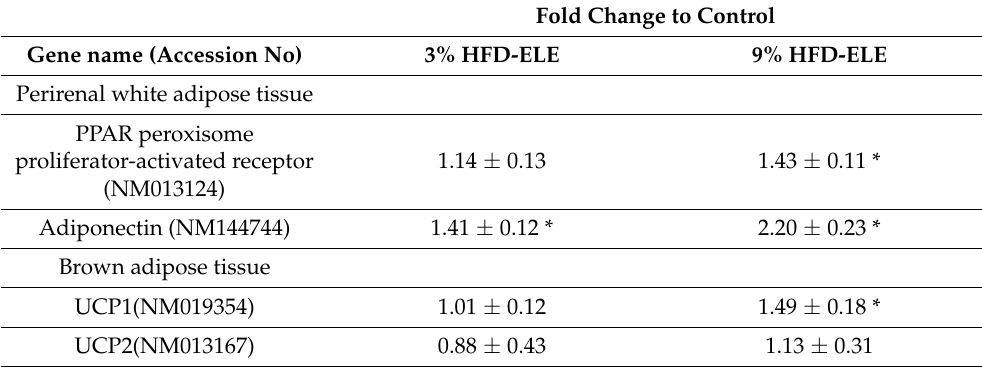
Table 4. Gene expression analysis by real-time PCR in adipose tissue after a three-month administra- tion of ELE in HFD-fed